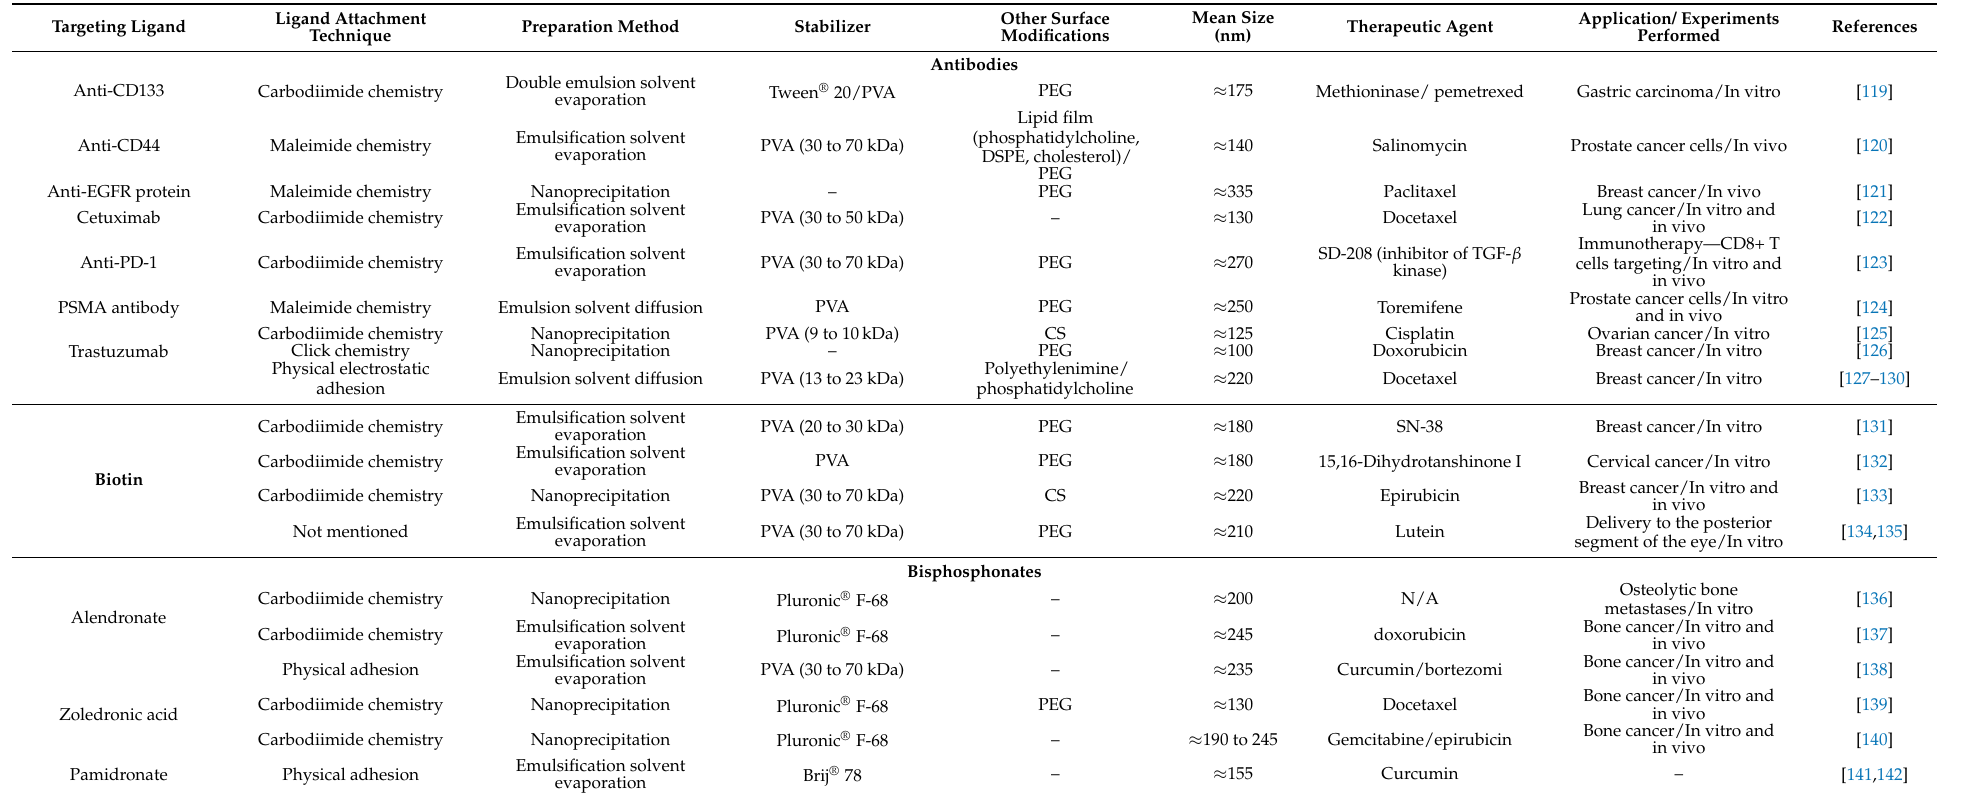
Table 5. Summary of recently developed PLGA-based NP surfaces functionalized with targeting ligands. 5-FU: 5-fluorouracil; CPP: cell-penetrating peptide; DSPE-PEG: 1,2-distearoyl- sn -glycero-3-phosphoethanolamine- N -[amino(polyethylene glycol)]; ICG: indocyanine green (fluorophore); PSMA: prostate-specific membrane antigen; RGD: arginine-glycine-aspartic